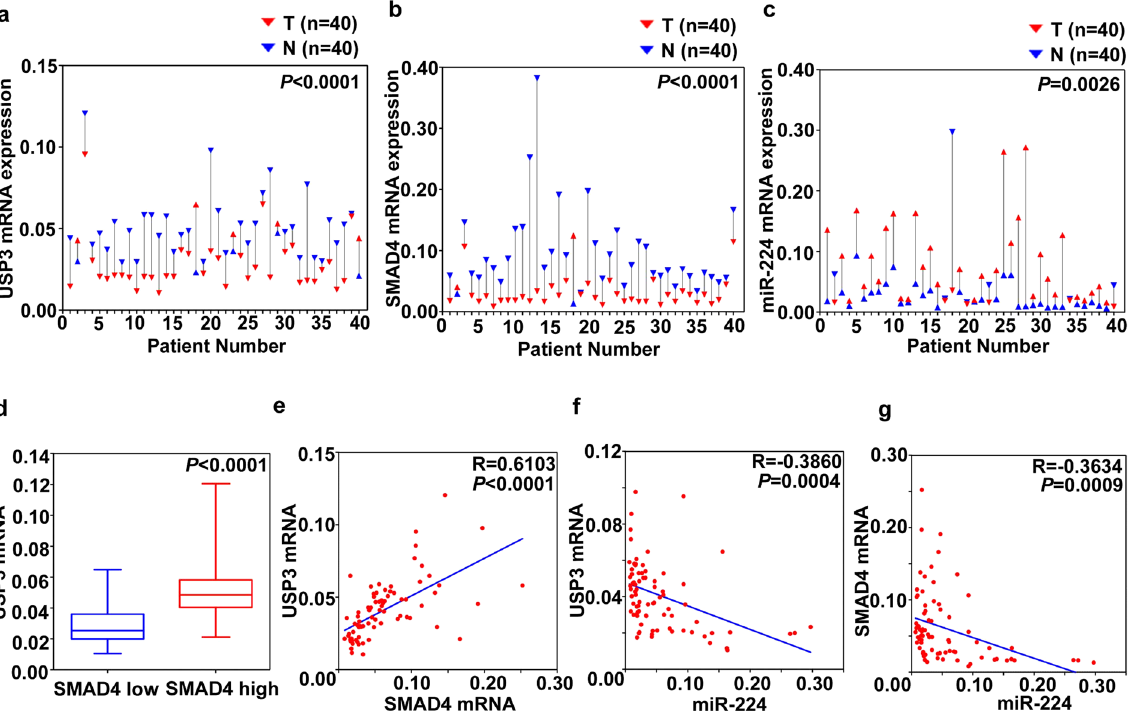
Figure 5. Expression and correlation of USP3, SMAD4 and miR-224 in primary CRC samples ( a–c ) USP3, SMAD4 and miR-224 expression in 40 paired primary CRC and adjacent non-cancer tissues were evaluated by qRT-PCR. ( d ) Comparison of the USP3 expression levels between “SMAD4 low” and “SMAD4 high” subgroups that were classified according to the median SMAD4 expression levels. ( e–g ) Correlation analyses of USP3 mRNA, SMAD4 mRNA and miR-224 were conducted in these CRC specimens.